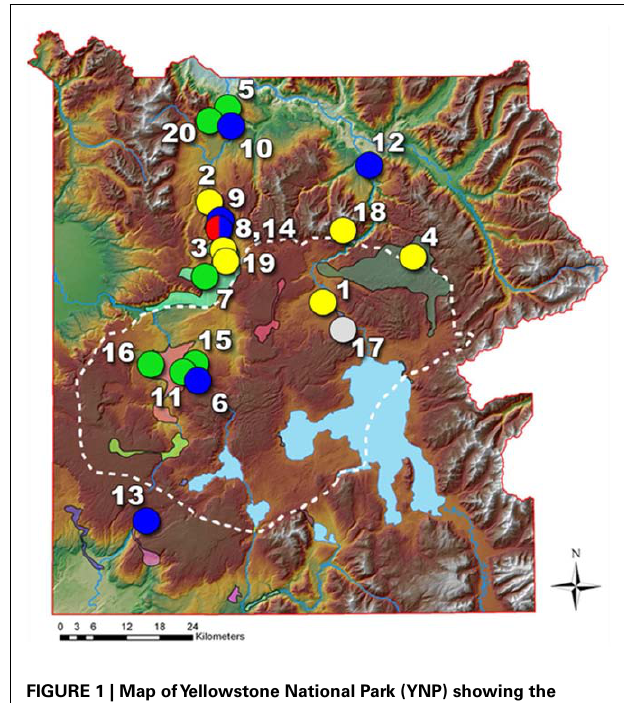
FIGURE 1 | Map ofYellowstone National Park (YNP) showing the locations of 20 geothermal sites sampled for metagenome and geochemical analysis (green = phototrophic sites; yellow/red = archaeal sites; blue = Aquificales “streamer” communities; gray = Obsidian Pool Prime; site numbers defined in Table 1) .The dashed line represents the boundary of the most recent